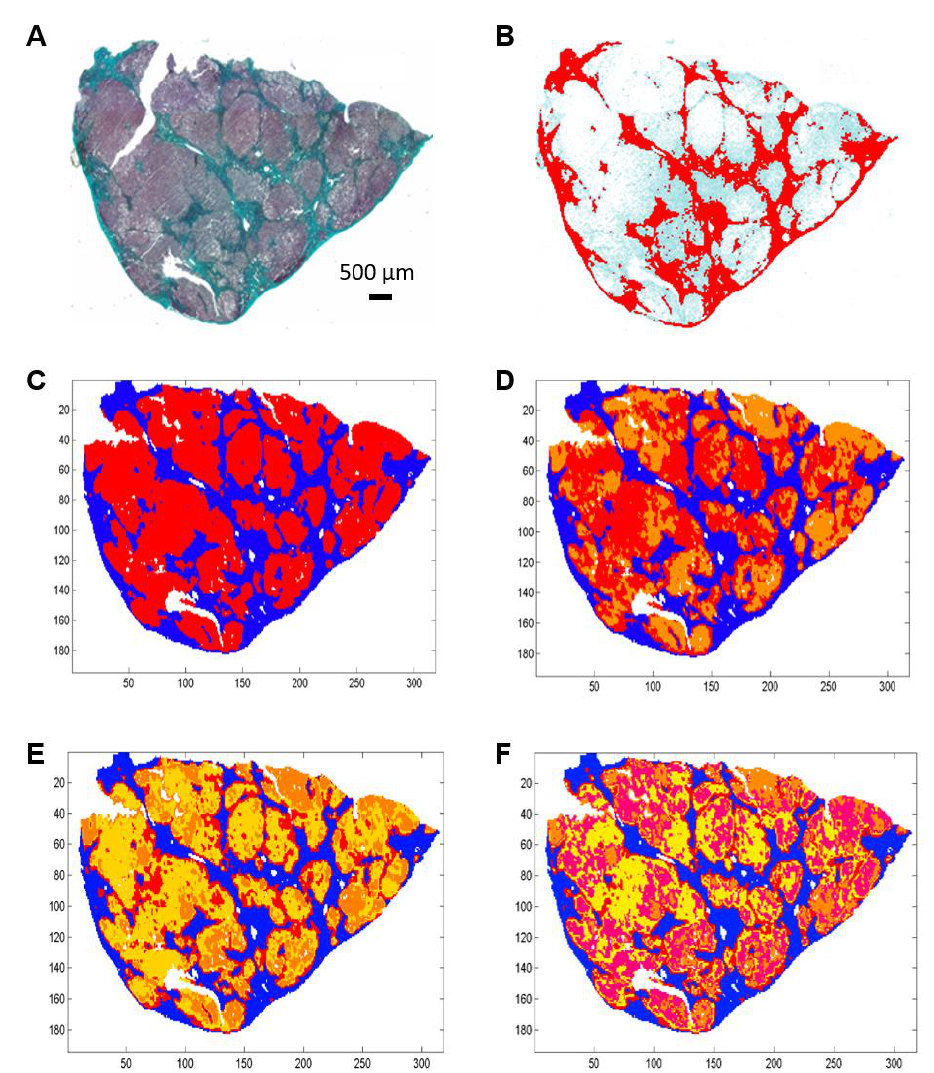
Figure 1. Example of histological and FTIR spectral images of an uncomplicated cirrhosis biopsy. ( A ) Histological section stained with Masson’s trichrome stain showing fibrosis in green. ( B ) Digital image analysis with fibrosis area in red. ( C – F ) K-means clustering of FTIR spectral images of an adjacent section in 2, 3, 4 and 5 clusters respectively from a 900–1800 cm − 1 infrared absorbance dataset acquired with a projected pixel size of 25 µ m. Clusters are displayed using random pseudo-colors. Fibrosis is represented by the dark blue cluster. Other colors correspond to regeneration nodules.